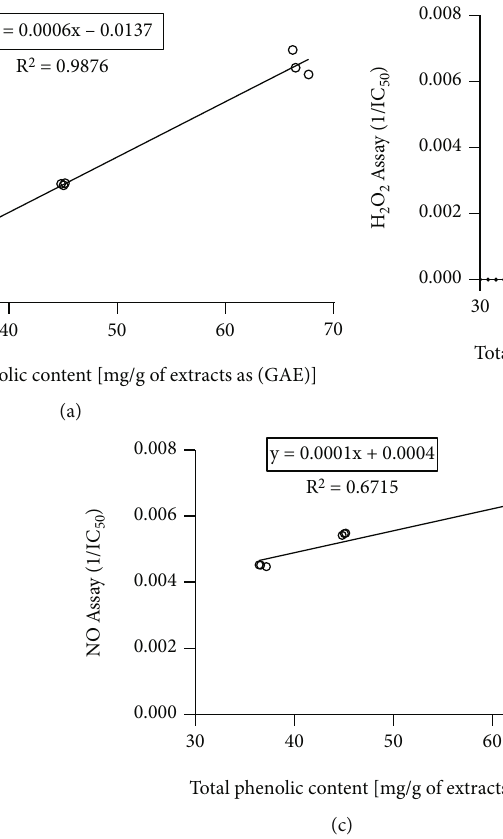
Figure 5: Correlation between total phenolic content and (a) DPPH radical scavenging activity of the extracts. Correlation coe ffi cient, r = 0 : 9851 and coe ffi cient of determination, R 2 = 0 : 9705 . (b) H 0 : 9449 and coe ffi cient of determination, R 2 = 0 : 8928 . (c) NO radical scavenging activity of the extracts. Correlation coe ffi cient, r = 0 : 8883 and coe ffi cient of determination, R 2 = 0 : 7890 .